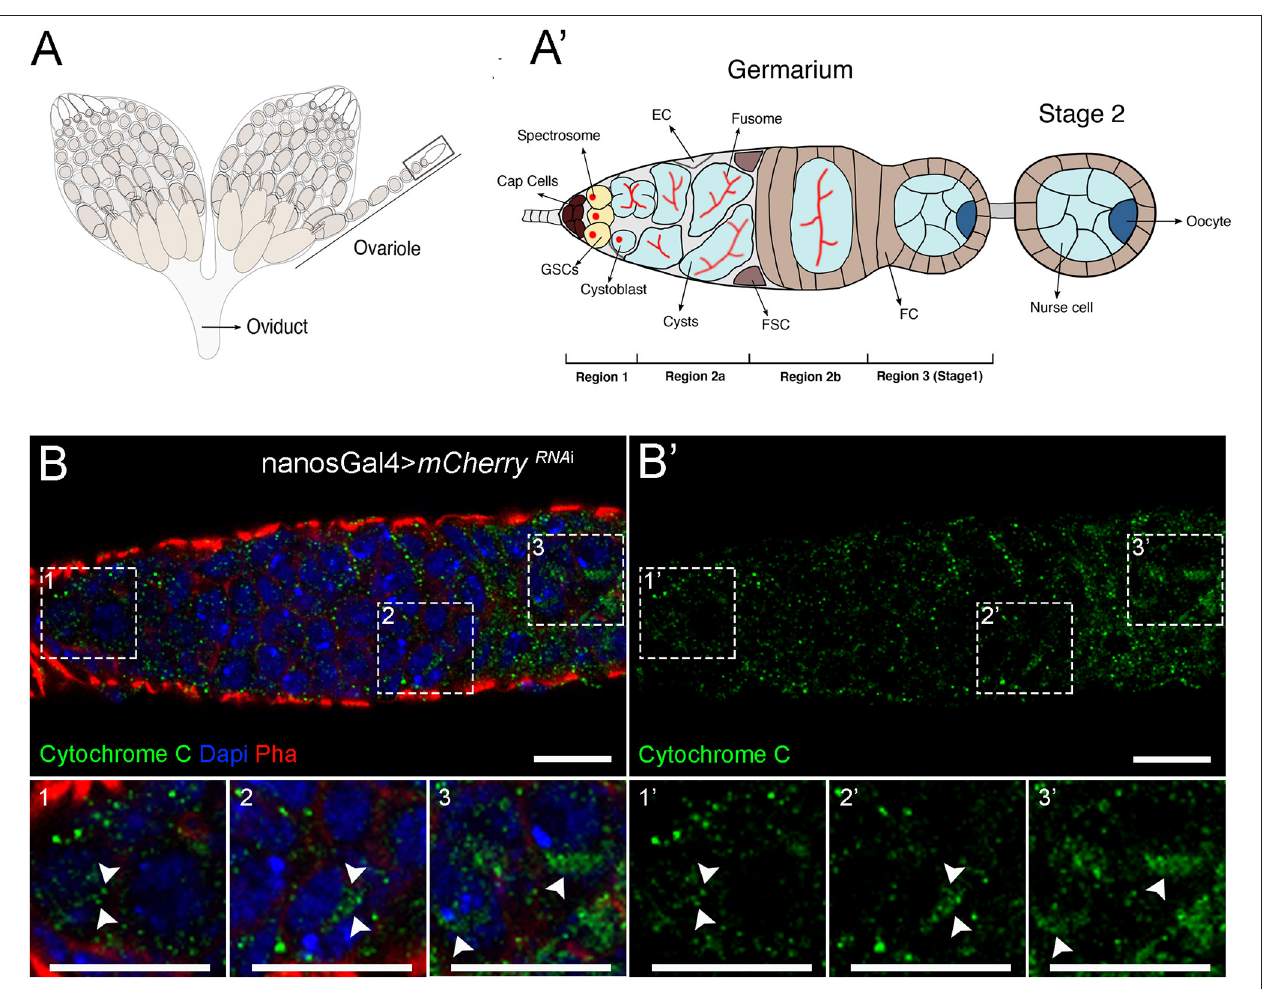
FIGURE 1 | Mitochondria undergo changes in morphology during cellular differentiation in the adult germarium. (A) Schematic representation of Drosophila ovaries illustrating the different stages of egg formation in the ovarioles. (A ′ ) Enlarged view of the germarium. The germarium is located at the most anterior part of the ovariole (black box outlined in A ). At the most anterior tip of the germarium (region 1) reside the germ stem cells (GSCs). GSCs are connected to niche cells, the cap cells, and are characterized by the presence of round spectrosomes. GSCs divide to self-renew and form one cystoblast that occupies a more posterior position and is not in direct contact with cap cells. The cystoblast starts differentiation and divides to give rise to cysts (region 2a); this process is accompanied by the differentiation of the spectrosome into an elongated structure, the fusome. In region 2b, the cysts are encapsulated by follicle cells (FC), and in region 3, 1 out of the 16 cyst cells is specified as the oocyte (dark blue cell at the posterior side of the cyst), whereas the remaining 15 cells become nurse cells, supportive cells that will aid in oocyte development into one mature egg. Escort cells (ECs) and follicle stem cells (FSCs) are also represented. (B) Representative images of a control germarium (expressing mCherry RNAi driven by nos Gal4) showing staining for mitochondria in the different developmental regions. Mitochondria labeled by Cytochrome c staining are visualized in green (B ′ ) . GSCs mostly display punctate and fragmented mitochondria (1 and 1 ′ ) that progressively aggregate during cyst differentiation (2–3 and 2 ′ -3 ′ ), suggesting more fusion. Fissed and fused mitochondria in regions 1 (1 and 1 ′ ), 2b (2 and 2 ′ ), and 3 (3 and 3 ′ ) of the germarium are identified with arrowheads in zoomed areas (dashed white squares). Nuclei are labeled with DAPI (blue), and F-actin is labeled with Phalloidin (Pha, red). Scale bars represent 10 µ